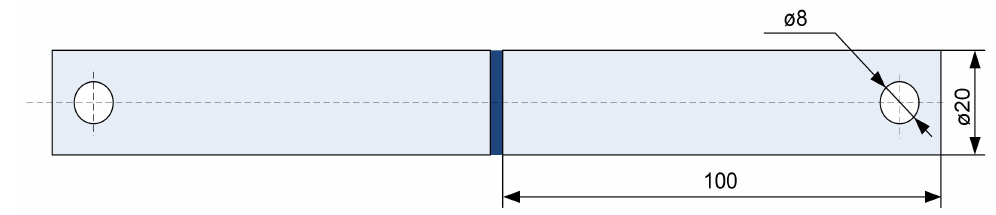
Figure 2. Cylindrical specimen comprising two bars butt-joined by adhesive